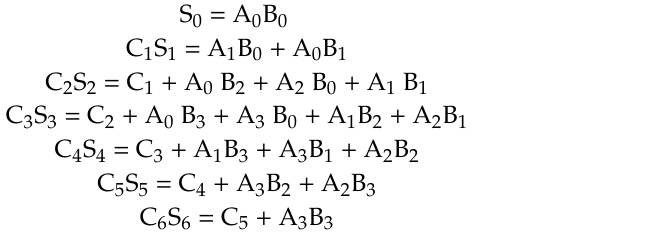
Figure 10. Full adder for designing ripple carry adder (RCA).